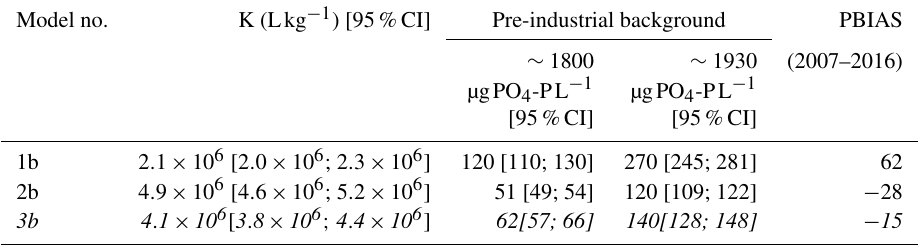
Table 2. The predicted concentrations of phosphate (PO 4 -PµgL − 1 ) in the Scheldt River based on the degree of phosphate saturation (DPS) in the sediment layers of marsh Old1, dating back to 1800 (pre-industrial), where DPS values stabilized with depth at 20%. The predicted concentration dated to 1930, where DPS stabilized at 36%. The PBIAS is the mean difference of simulated and observed data between 2007 and 2016, expressed as a percentage of the observed data. The conversion of DPS to river phosphate concentration is based on the association of DPS with PO 4 -P. That association was calibrated to data from 1967–2016, thereby using different sediment–water models; the details of models are in Table S2. Model 3b (in italics) is proposed as the most accurate (see text). Model no. K (Lkg − 1 )